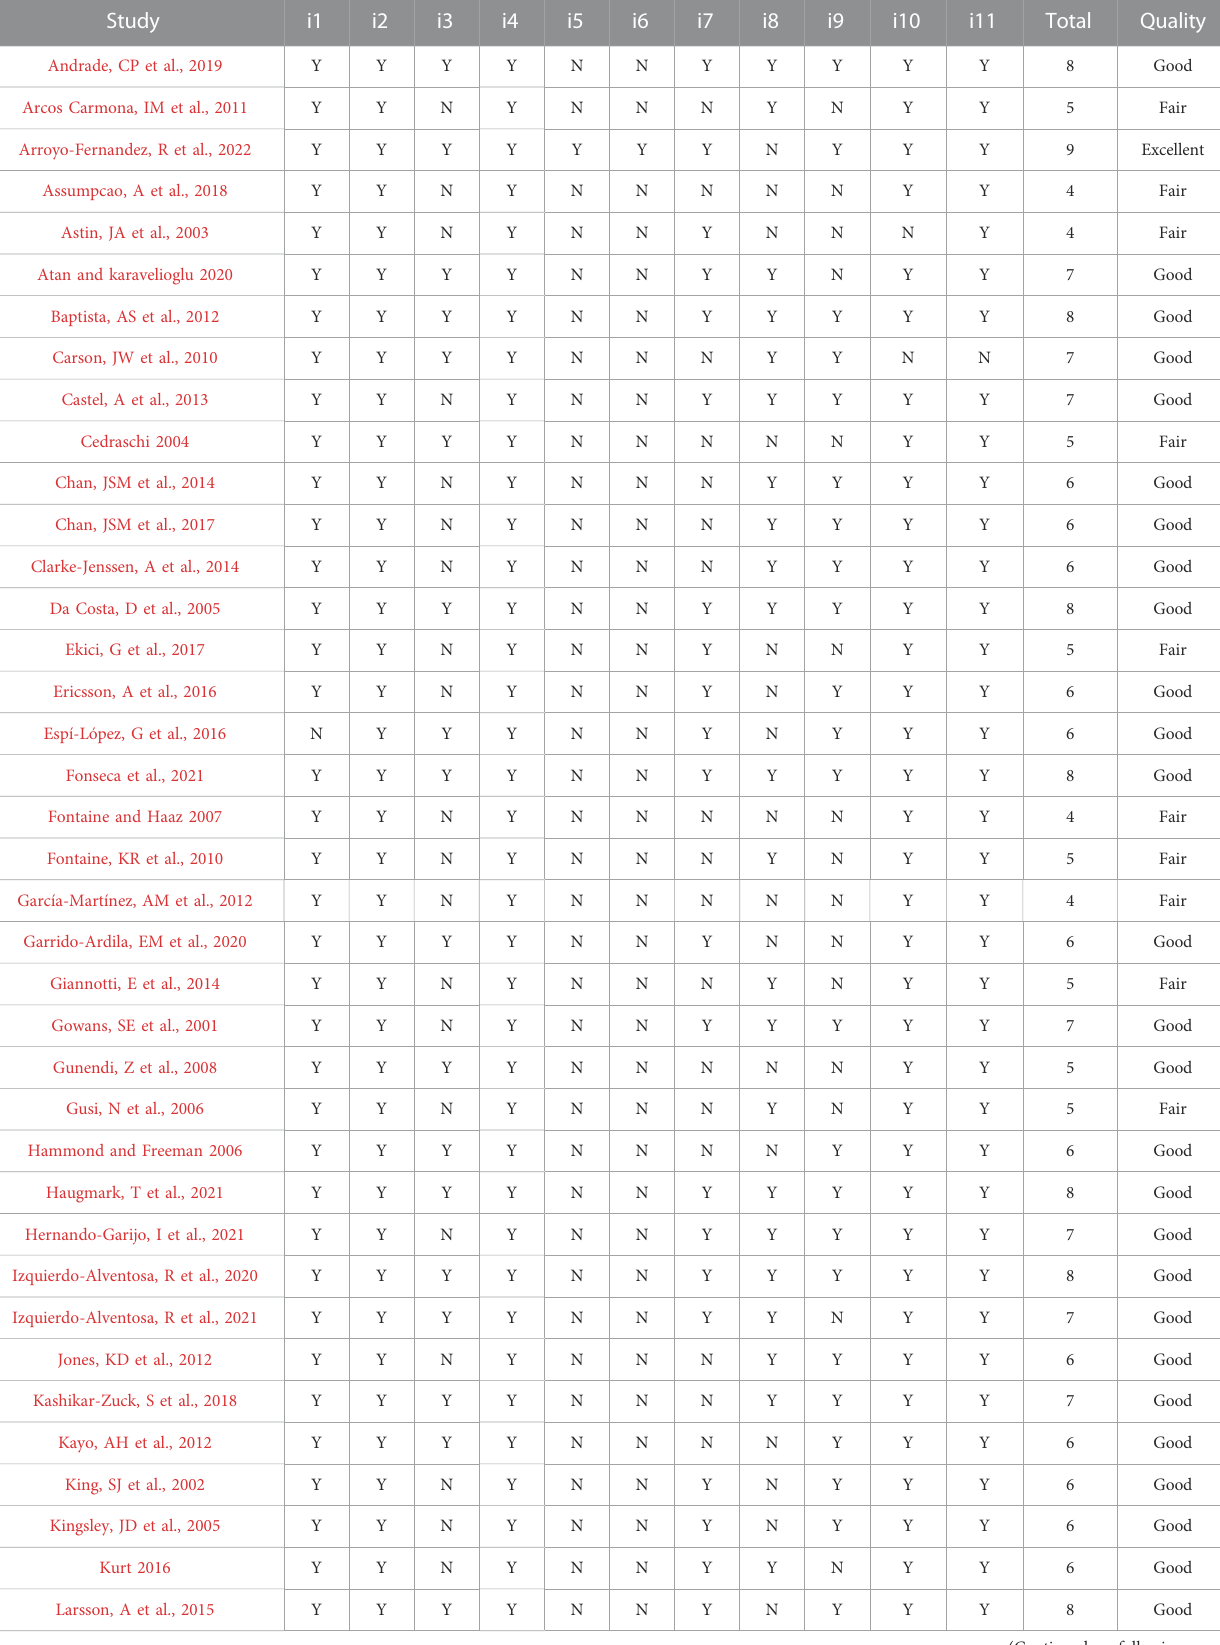
TABLE 1 PEDro scores for methodological quality and risk of bias assessment in the studies included in the systematic review and meta-analysis.